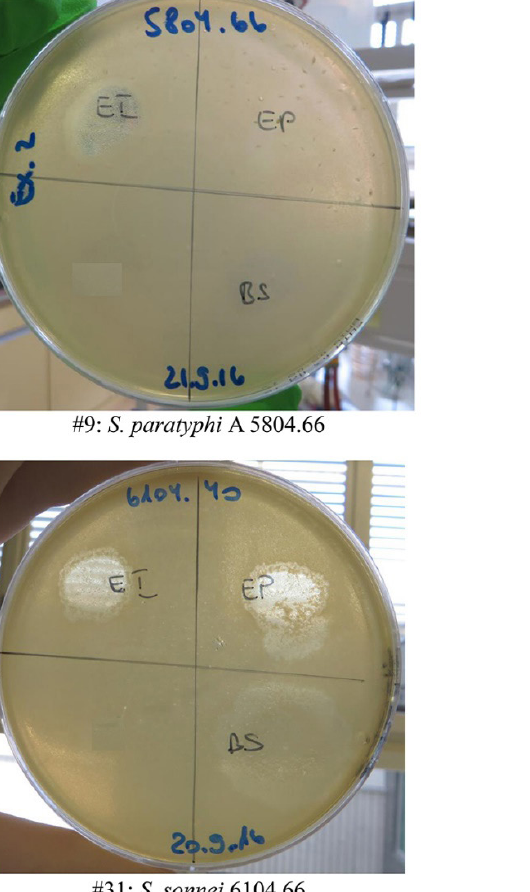
Supplementary Figure 1. Examples of bacteriophage susceptibility results (see Supp. Table 1) for 2 Salmo- nella and 2 Shigella spp. strains. EI, Eliava INTESTI Bacteriophage cocktail; EP, Eliava PYO Bacteriophage (Eliava) cocktail; BS, Biochimpharm Septaphage Bacteriophage